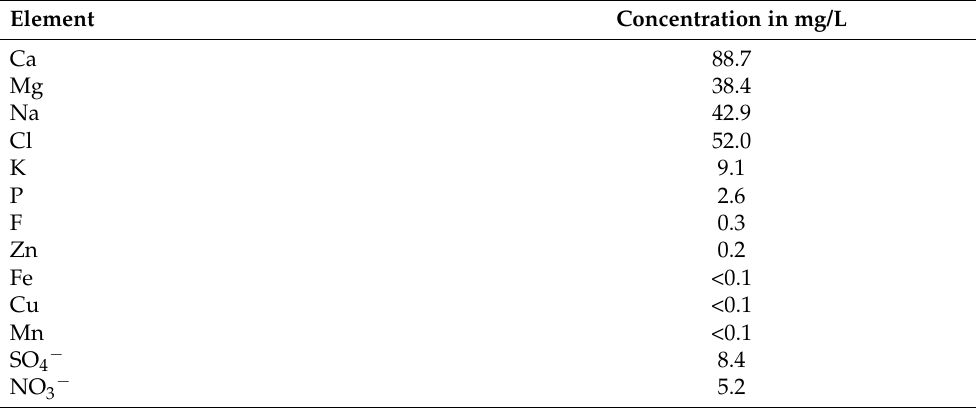
Table 6. Chemical composition of tap water used in this